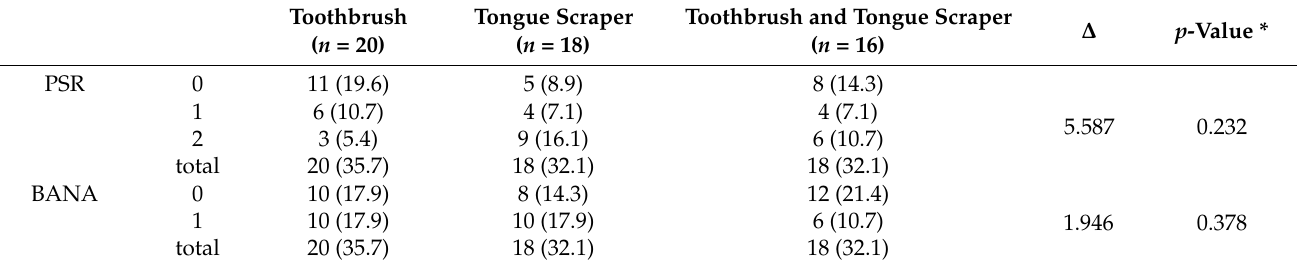
Table 2. Oral health status of the subjects (PSR, BANA) n